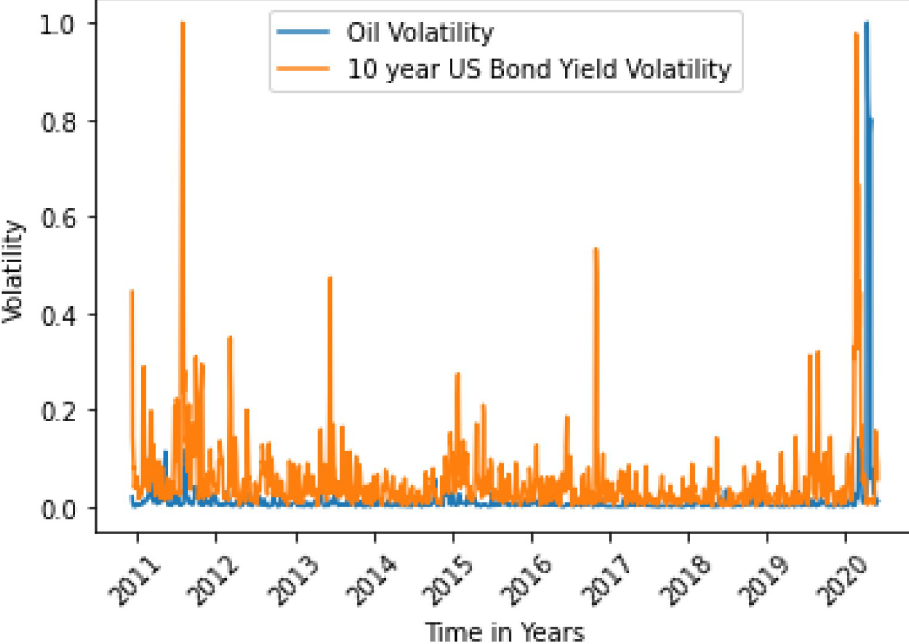
Fig 13. US 10 yr Bond Yield variance does not Granger cause oil variance. Here, the correlation between two data is 0.0241.